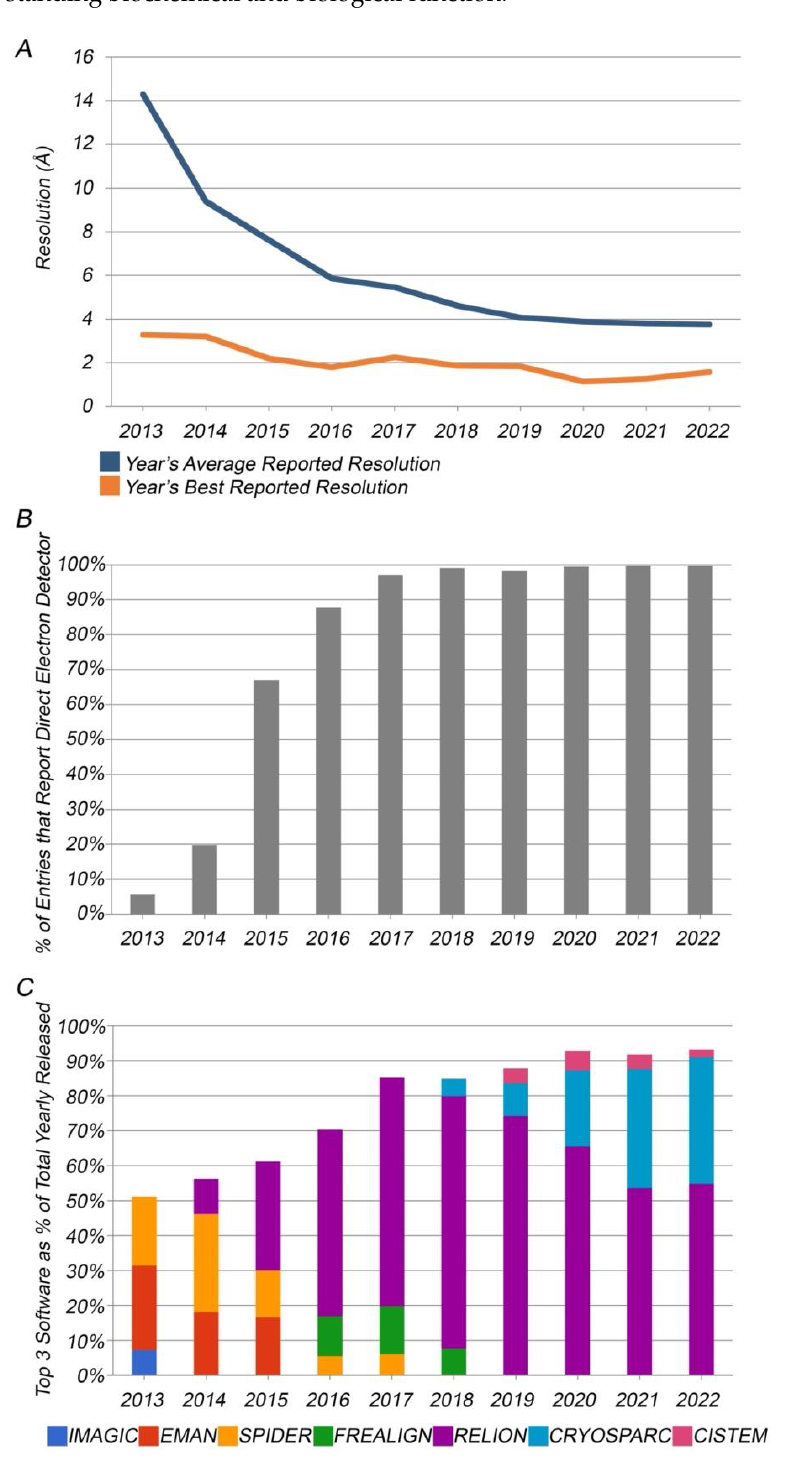
Figure 5. ( A ). Annual average reported resolution (blue) and annual best reported resolution (orange) for 3DEM PDB structures released 2013–2022. ( B ). Percentage of 3DEM PDB structures released per year reporting use of direct electron detectors. ( C ). Top-three reported image reconstruction software packages per year shown as a percentage of 3DEM PDB structures reporting reconstruction software.